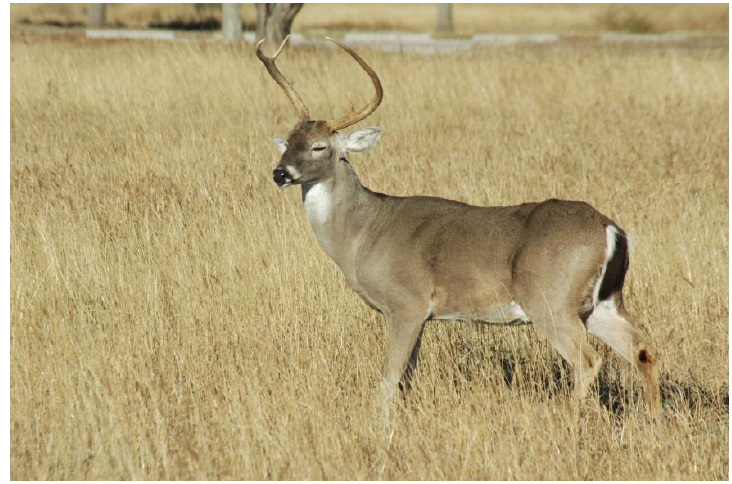
Figure A1. Male white-tailed deer ( Odocoileus virginianus ) exhibiting lower range of antler points for adult deer (visually estimated ≥2.5 years). Photograph by Stephen L. Webb.